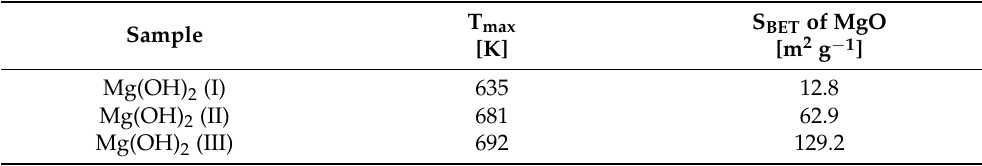
Table 9. Thermal analysis results of magnesium hydroxide samples (batch III) and specific surface area of MgO obtained from the decomposition at the temperature of 873 K (1 h in air and 5 h in nitrogen).